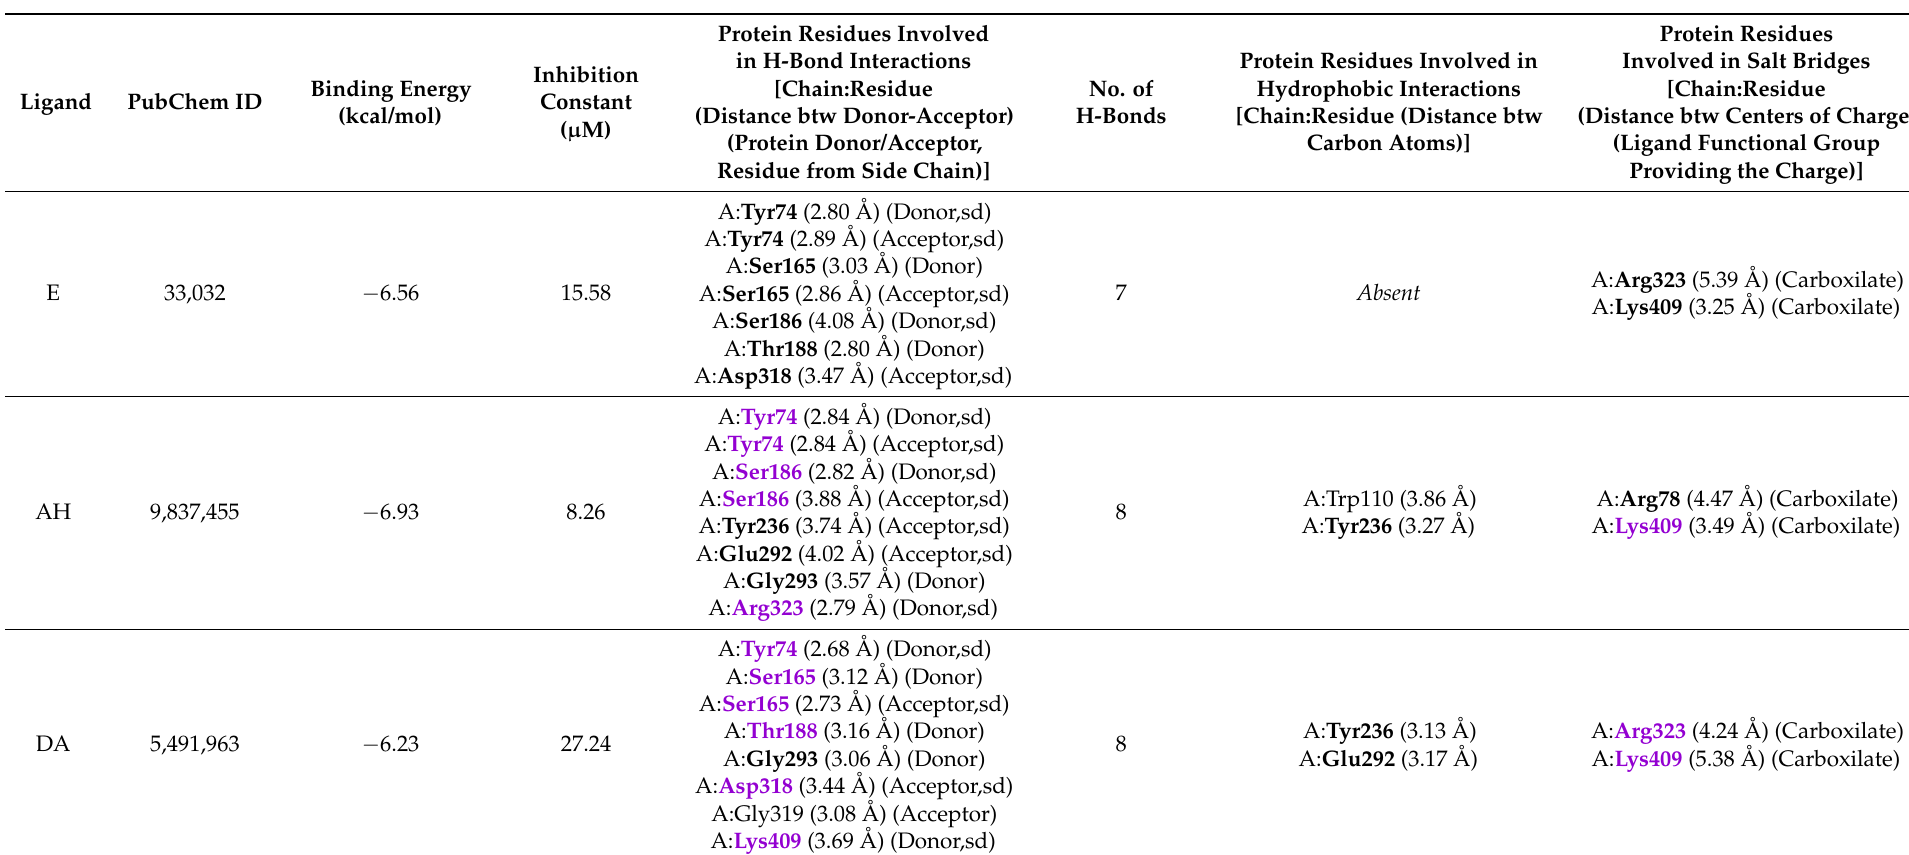
Table 2. Rattus norvegicus closed–open conformation (PDB ID: 1EWK) of mGluR1 residues involved in docking interactions with glutamic acid and the umami dry-cured ham dipeptides of this study, with docking